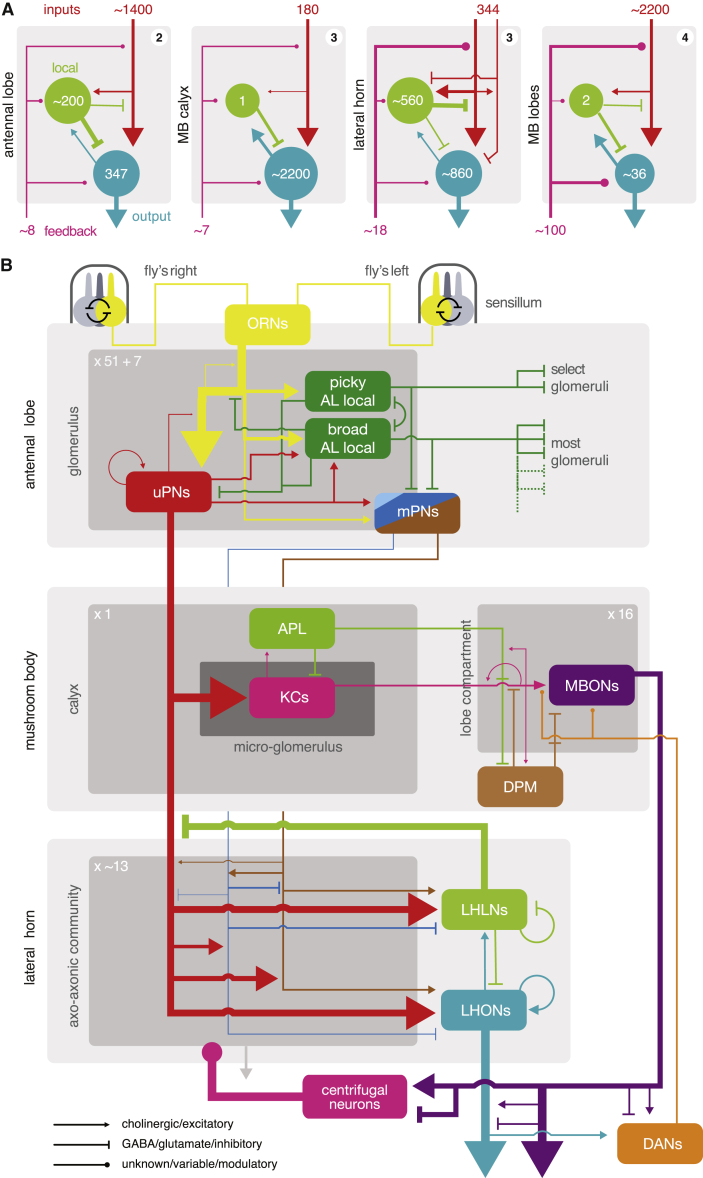
Summary Wiring Diagrams of the D. melanogaster Olfactory System(A) Basic wiring diagrams for four major olfactory neuropils in the fly brain, in terms of input, local, output, and feedback neurons. Line widths approximate the strength of neuron-to-neuron connections.(B) The overall layout of the olfactory system of D. melanogaster, including LH wiring uncovered by the present study. Note that connectivity as regards to LHNs is based on 82/∼1,400 LHNs and so represents connection types we have observed, though others may exist. 1,400 ORNs, 2,200 KCs, ∼200 AL LNs, 347 PNs, 35 MBONS, 10 MB LH Cent, 8 AL feedback (e.g., AL-MDBL), 100 DANs, 1 APL, 1 DPM, 560 LHLNs, and 830 LHONs [8, 10, 31, 46, 60, 71]. Feedback neurons to the AL have not previously been observed (except for the clearly unpolarized CSD neurons [72]); we found and partially reconstructed a further seven examples of neurons with dendrites in the superior protocerebrum and a putative axon in the AL (data not shown). Examined LHLNs have all proven GABAergic or glutamatergic and most LHONs have been shown to be cholinergic [14].